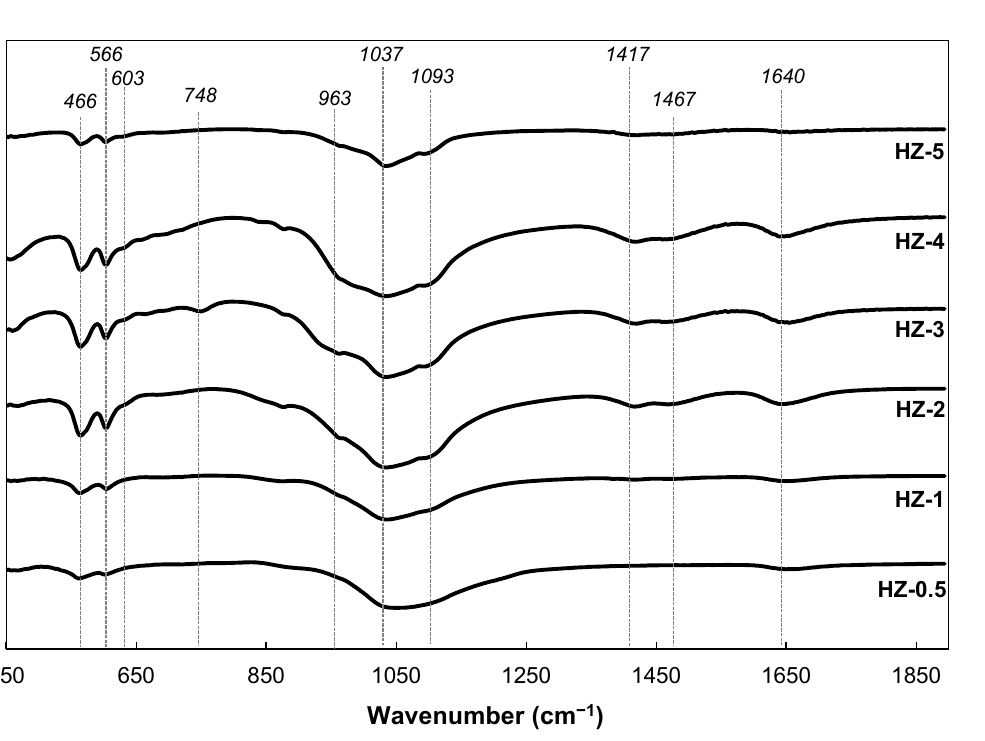
Figure 2. The FT-IR spectra of the synthesized composite samples.